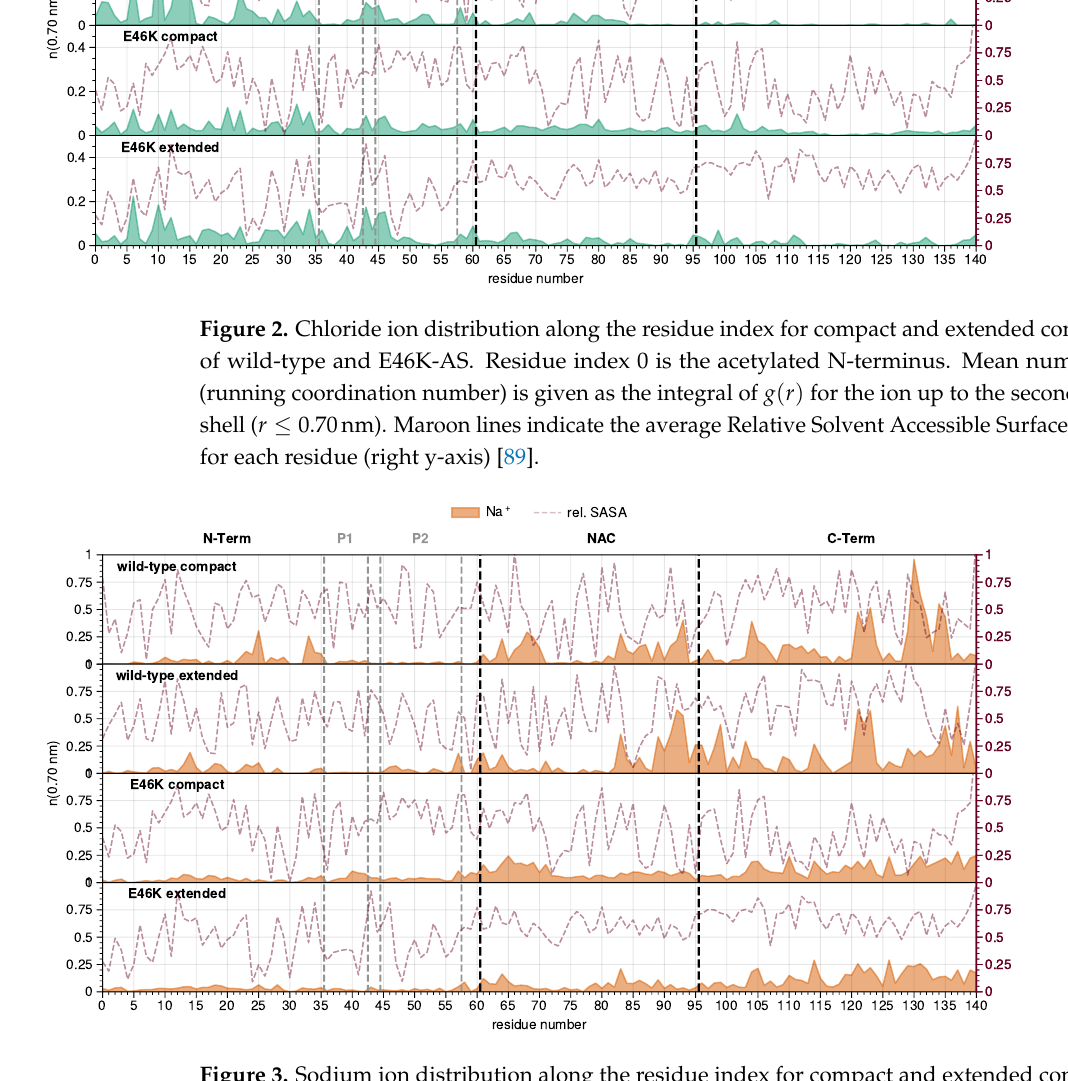
Figure 3. Sodium ion distribution along the residue index for compact and extended conformations of wild-type and E46K-AS. Residue index 0 is the acetylated N-terminus. Mean number of ions (running coordination number) is given as the integral of g ( r ) for the ion up to the second hydration shell ( r ≤ 0.70nm). Maroon lines indicate the average RSA for each residue (right y-axis)